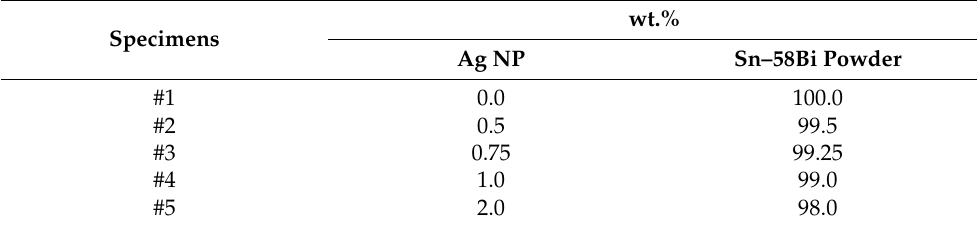
Table 1. Compositions of solder